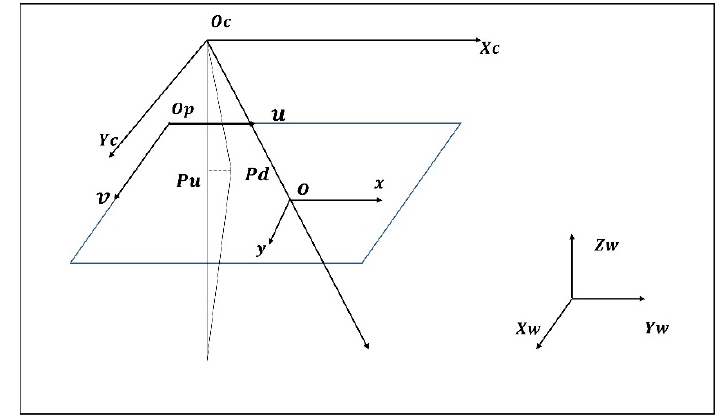
Figure 4. Coordinate system of measurement system.